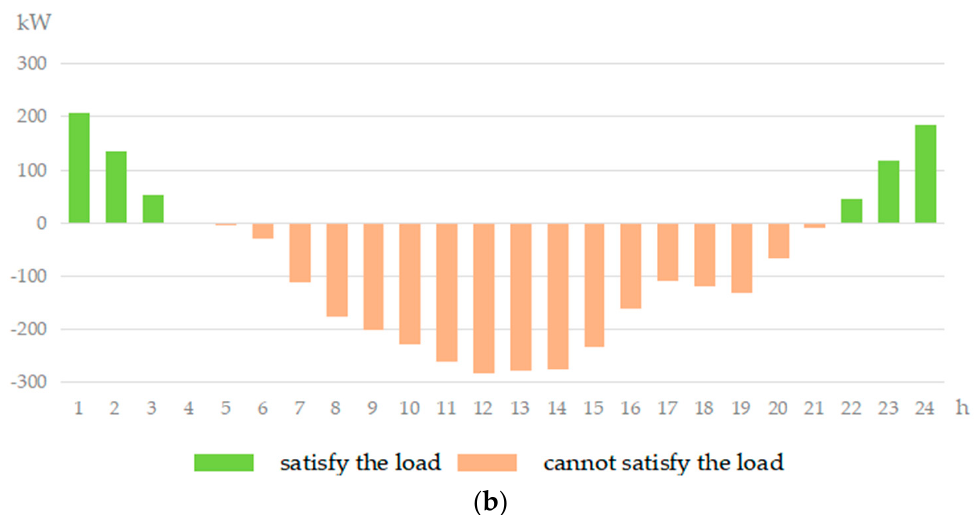
Figure 7. Supply-to-load curves of wind and PV power and small hydropower stations: ( a ) small hydropower station output after meeting the load demand; ( b ) wind and PV power and small hydropower station supply-to-load curves.